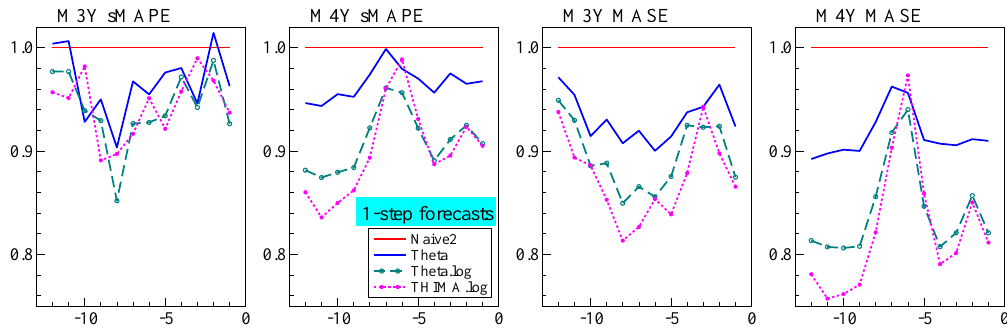
Figure 5. Average one-step ahead forecast accuracy for yearly M3 and M4, withholding from 12 to 1 observations at the end from the full datasets. Normalized by the naive